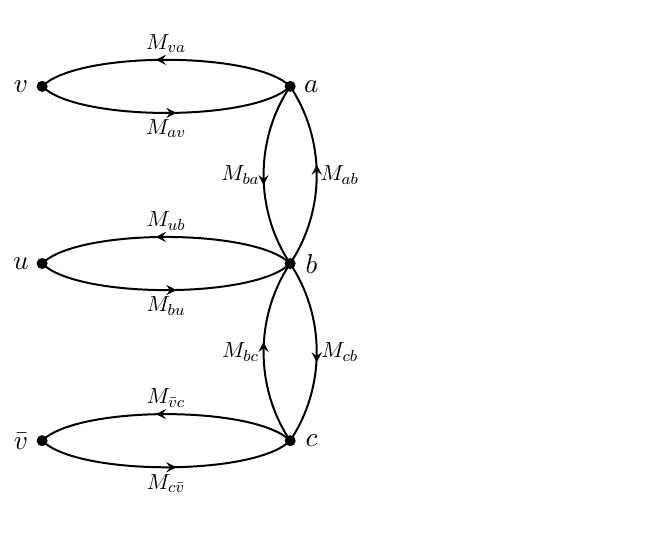
Figure 6 . Represents a quiver diagram where the arrows indicate the linear maps M av , M va , M ab , M ba , M bu , M ub , M bc , M cb , M c ¯ v , M ¯ vc and dots the spaces v , a , u , b , c , ¯ v on which they